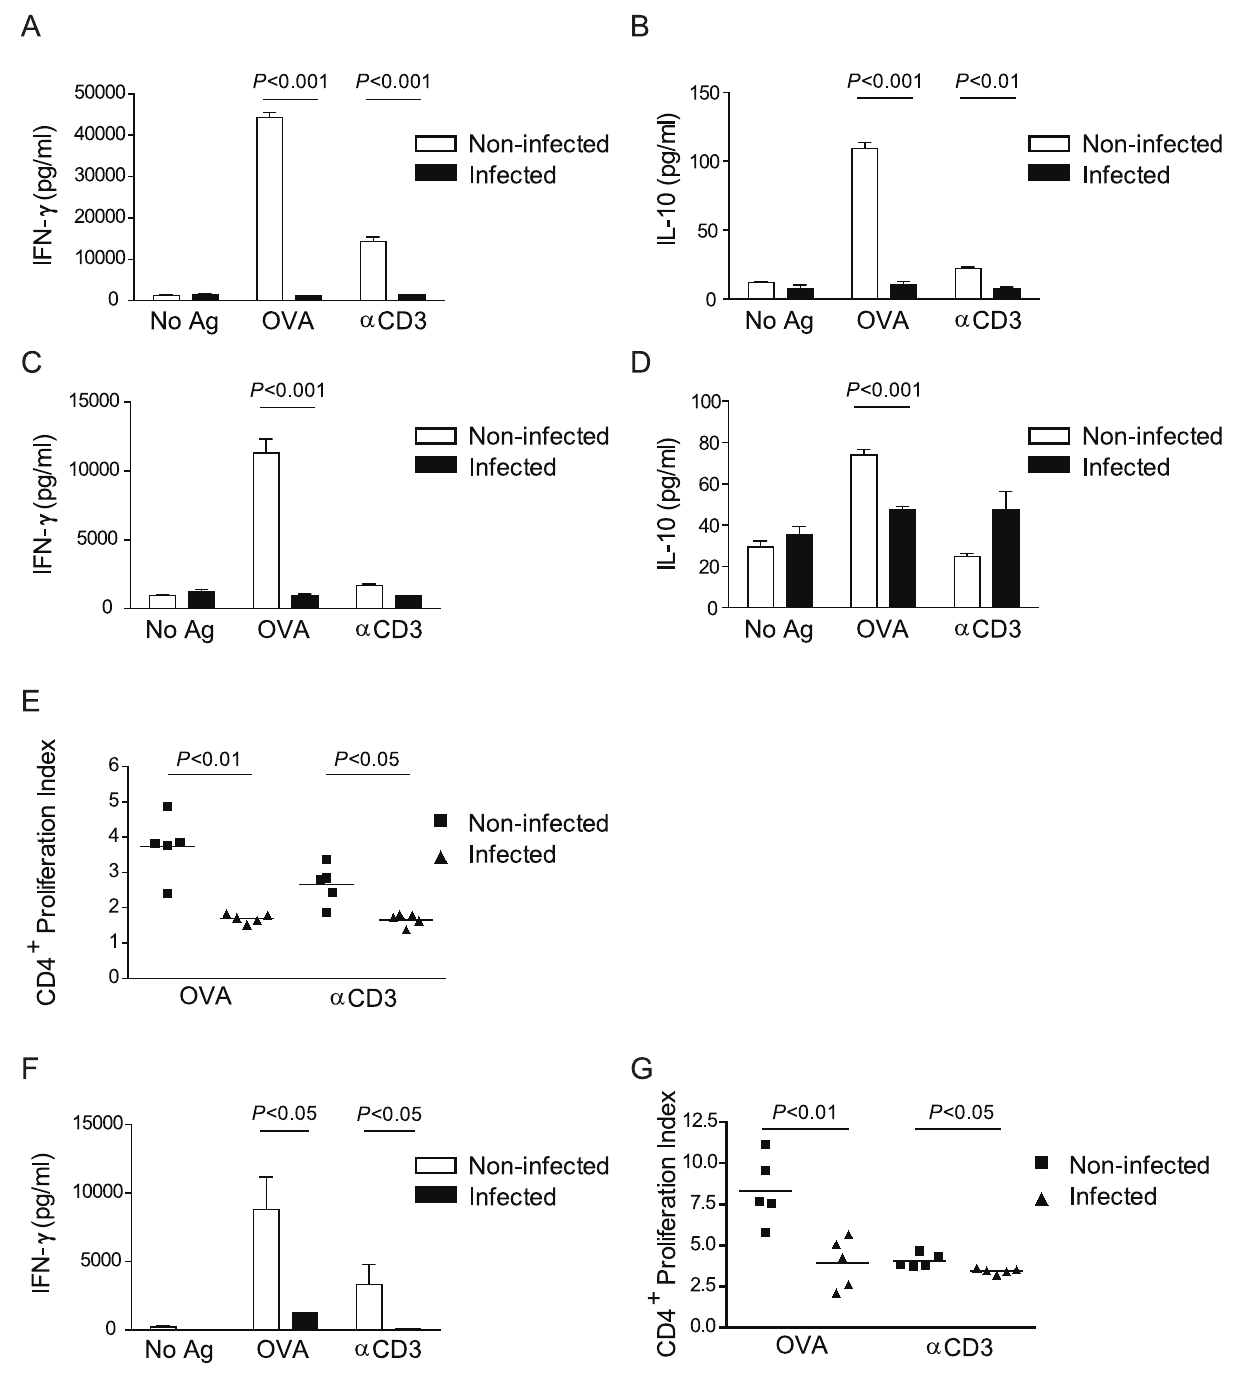
Figure 2. Pre-patent schistosome infection impairs CD4 + T cell responses to non-schistosome antigens. A–D, Splenocytes (A–B) or hepatic leukocytes (C–D) isolated from 4 week S. mansoni -infected or non-infected OT-II/RAG-1 2 / 2 mice were cultured in vitro for 72 hours without antigen, or in the presence of OVA peptide or anti-CD3 antibody. The concentration of IFN- c (A,C) or IL-10 (B,D) in the cell culture supernatant was measured by ELISA. Data shown are mean + / 2 SEM. E, Splenocytes were isolated from 4 week-infected or non-infected OT-II/RAG-1 2 / 2 mice, stained with CFSE, and cultured for 72 hrs with OVA peptide or anti-CD3 stimulation. Cells were recovered from culture, stained for surface markers, then CFSE dilution due to cell division was analyzed by flow cytometry and proliferation index calculated. Horizontal bars represent mean value of 5 independent mice. F–G, Splenocytes were isolated from 4 week S. mansoni -infected or non-infected RAG-1 2 / 2 mice; CD4 + T cells were isolated from non-infected OT-II/RAG-1 2 / 2 mice and stained with CFSE. Cells were then co-cultured for 72 hours without antigen or in the presence of OVA peptide or anti-CD3 antibody. The concentration of IFN- c in cell culture supernatants was measured by ELISA (F) and CD4 + T cell proliferation was analyzed by flow cytometry (G). Data are representative of at least 3 independent experiments. No Ag, no antigen; OVA, OVA peptide; a CD3, anti- CD3.